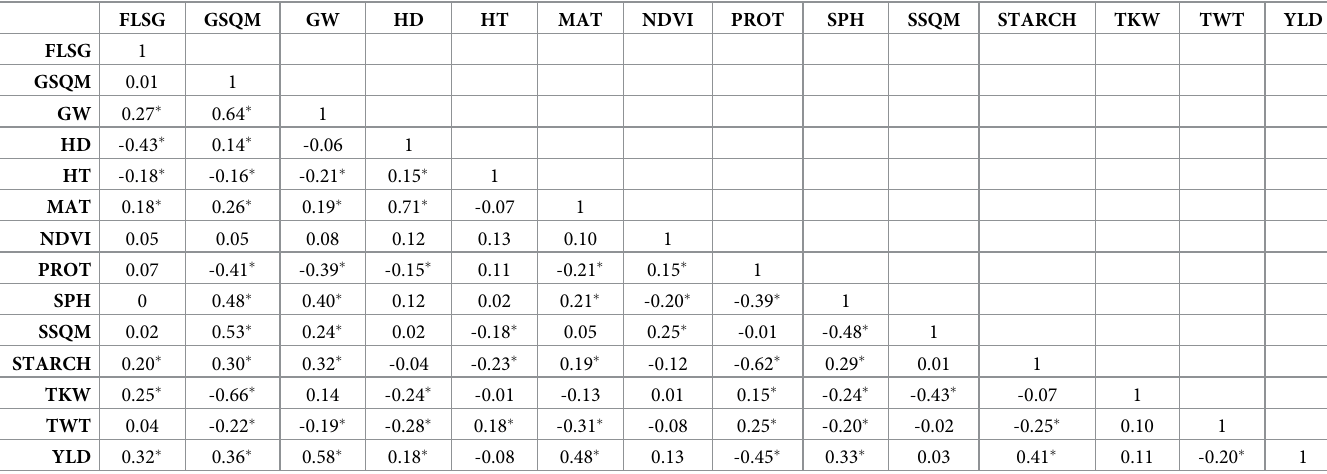
Table 2. Phenotypic correlations among traits calculated using the across-environment genotype BLUPs.